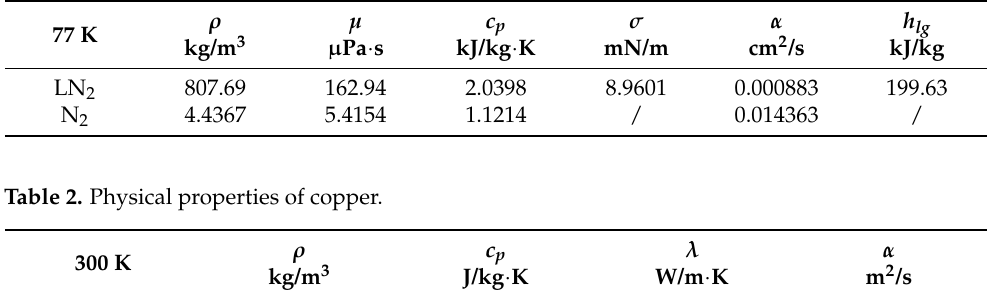
Table 1. Physical properties of fluids.